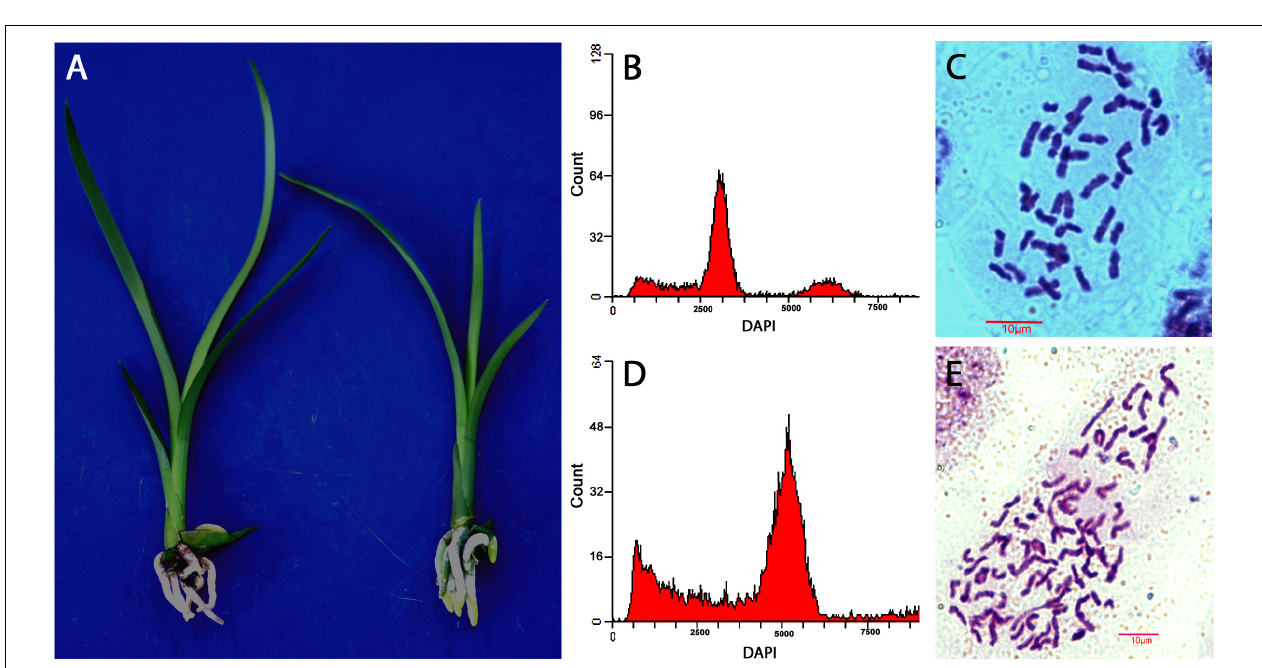
FIGURE 2 | Evaluation of ploidy levels of Cymbidium hybrids of “DH” and “Huanghe” resulted from cross of “Dafeng” × “Hezhihua.” (A) Morphology of “DH” (left) and “Huanghe” (right). (B) Flow cytometric DNA histograms of “DH” and (C) chromosome numbers of root tip cell of “DH” (2 n = 2 x = 40). (D) Flow cytometric DNA histograms of “Huanghe” and (E) chromosome numbers of root tip cell of “Huanghe” (2 n = 3 x = 60).